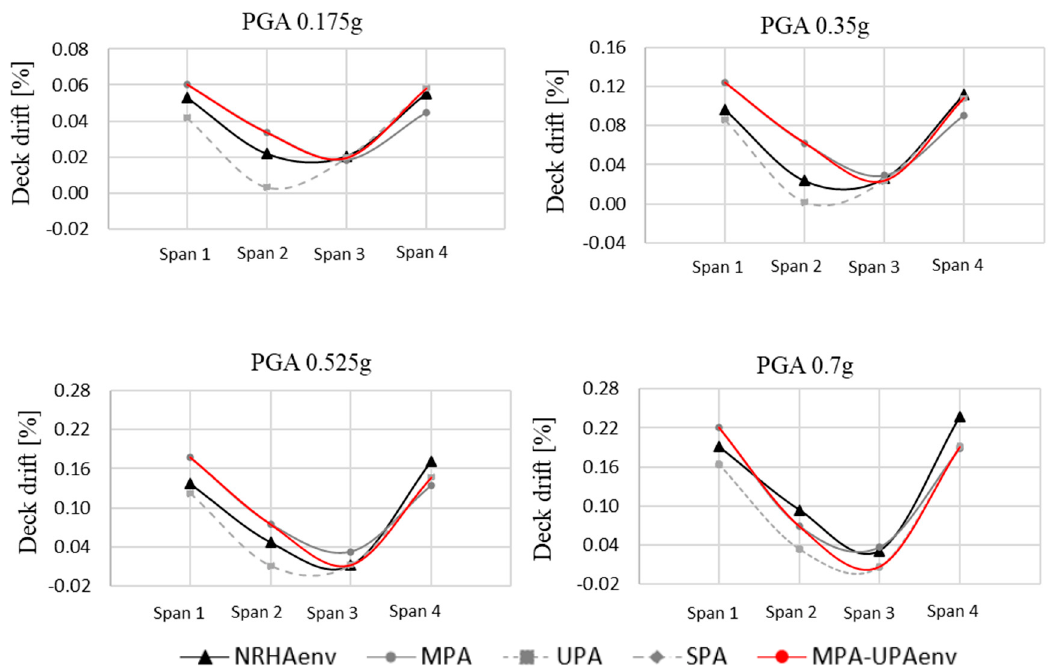
Figure 22. Irregular bridge—deck drift (relative disp. between two consecutive joints, P i and P i+1 /P i - P i+1 span length) derived by performing nonlinear dynamic analysis and pushover analysis according to the approaches considered (PGA 0.175–0.7 g).